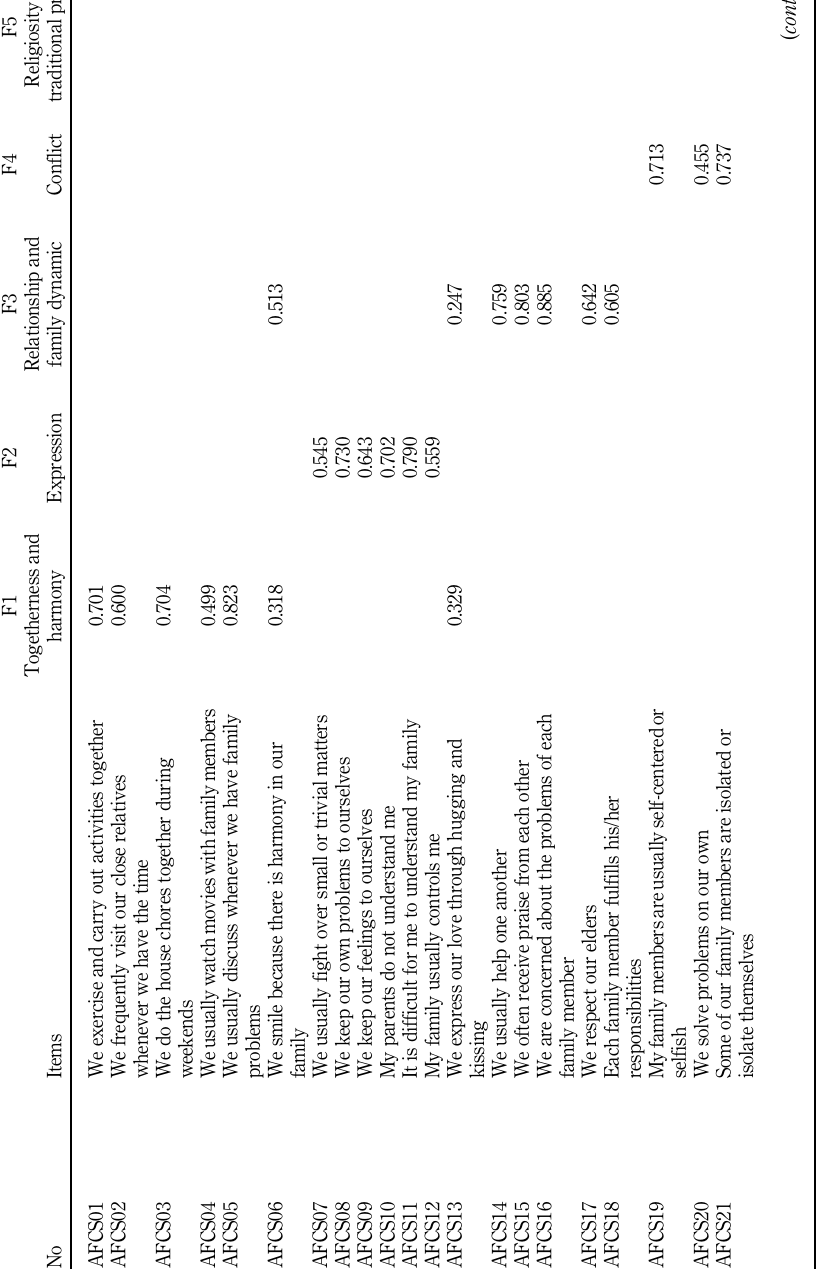
Table 2. Confirmatory